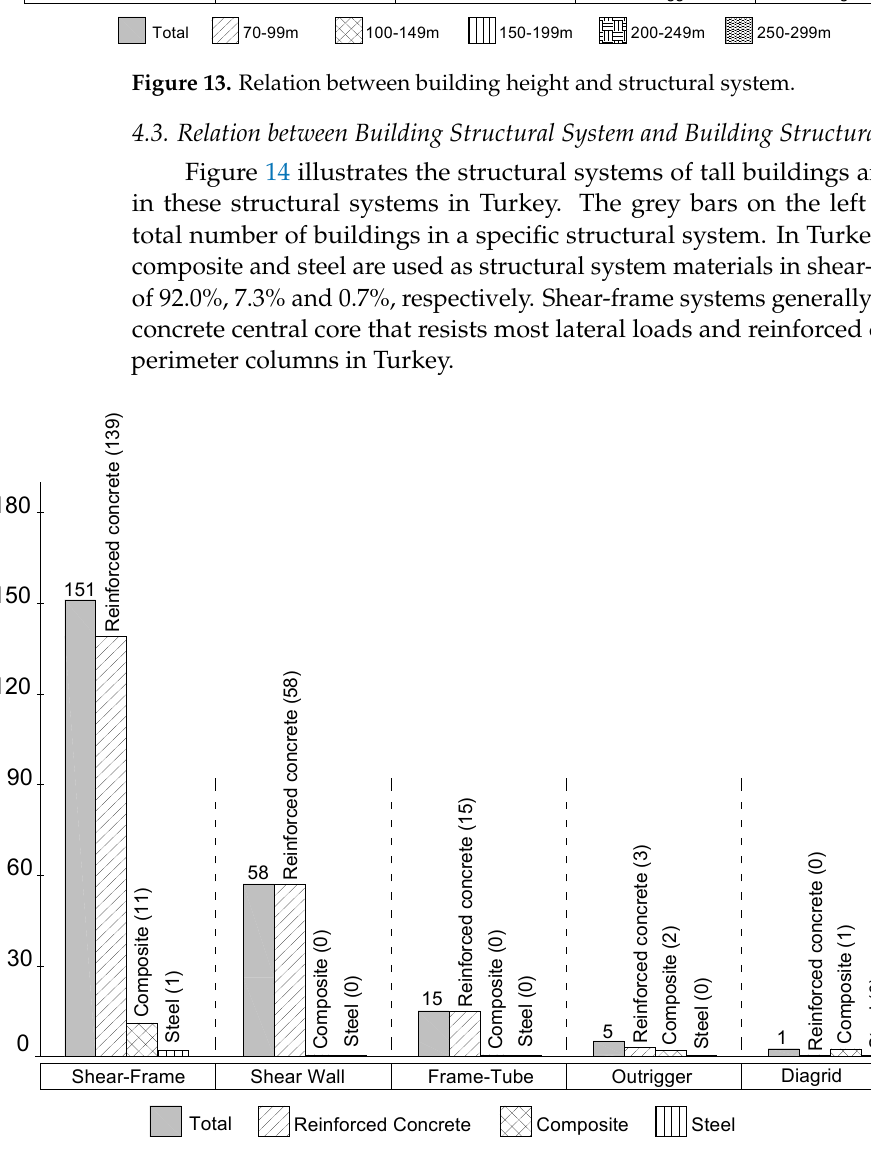
Figure 14. Relation between structural system and structural material.